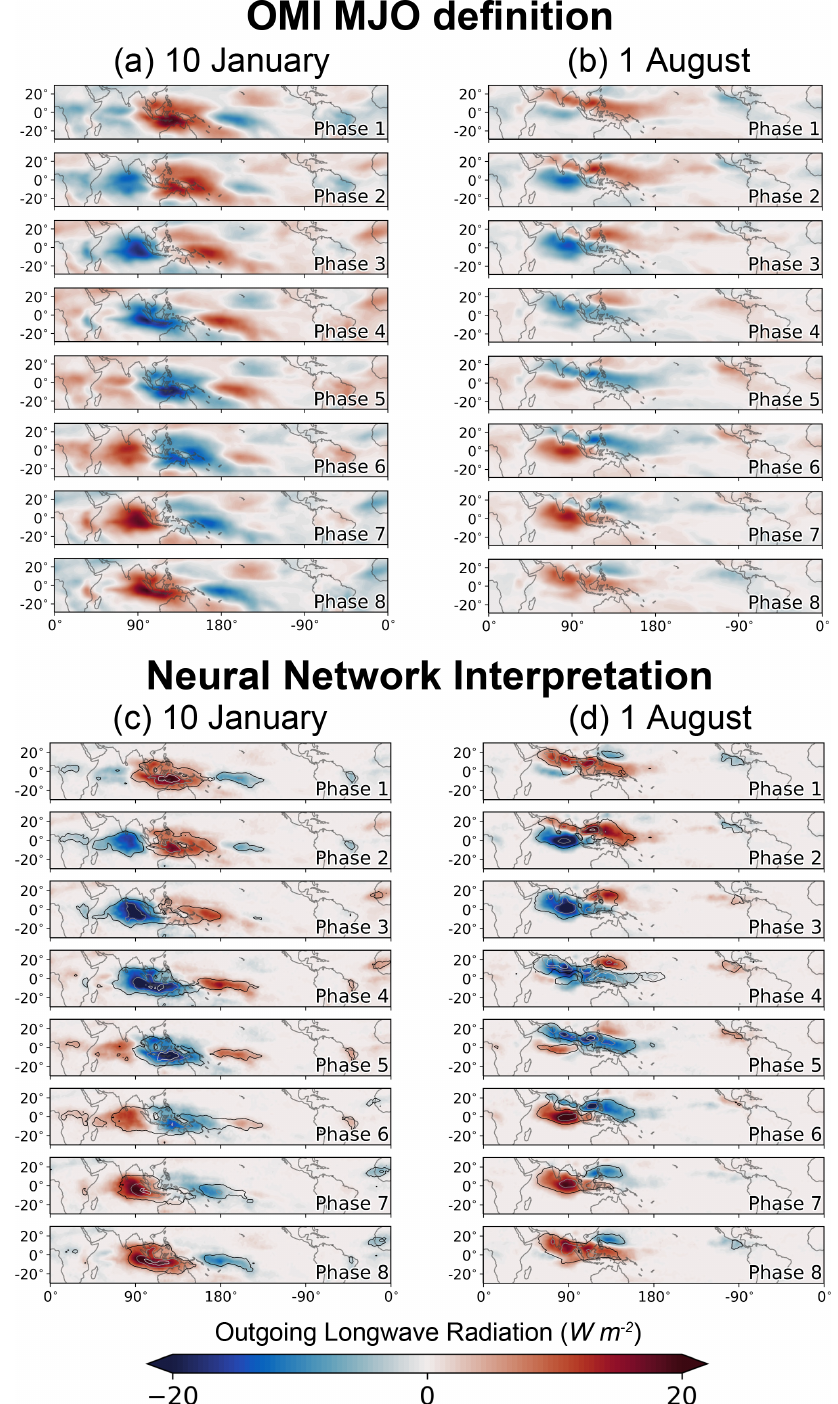
Figure 7. (a, b) The outgoing longwave radiation fields for each MJO phase according to the OMI for the boreal winter (10 January) and boreal summer (1 August) examples and those identified by the neural network. (c, d) The outgoing longwave radiation fields for each MJO phase according to the neural network based on the backward optimization and layerwise relevance propagation interpretation methods. The fill value shows the optimized outgoing longwave radiation patterns for each phase of the MJO, and the open contours show the composited relevance from LRP for all samples within each